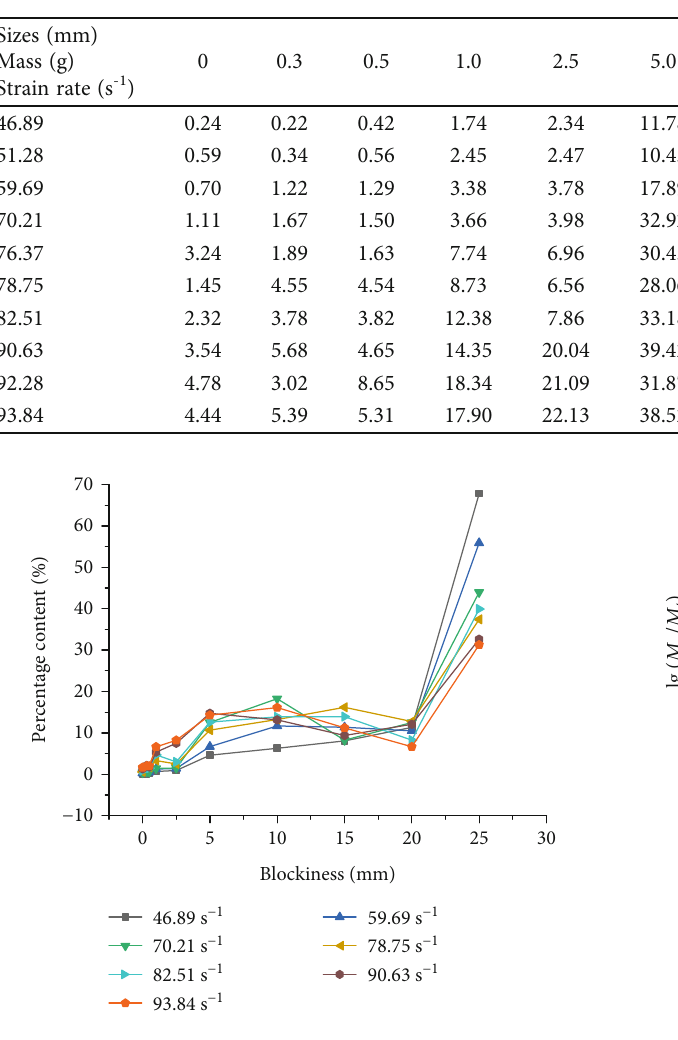
Table 3: Table of impact test sieve sizes corresponding to weighing masses.